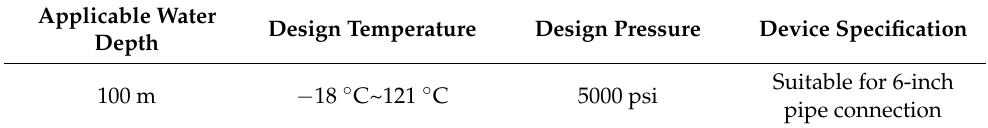
Table 1. Connector key technical